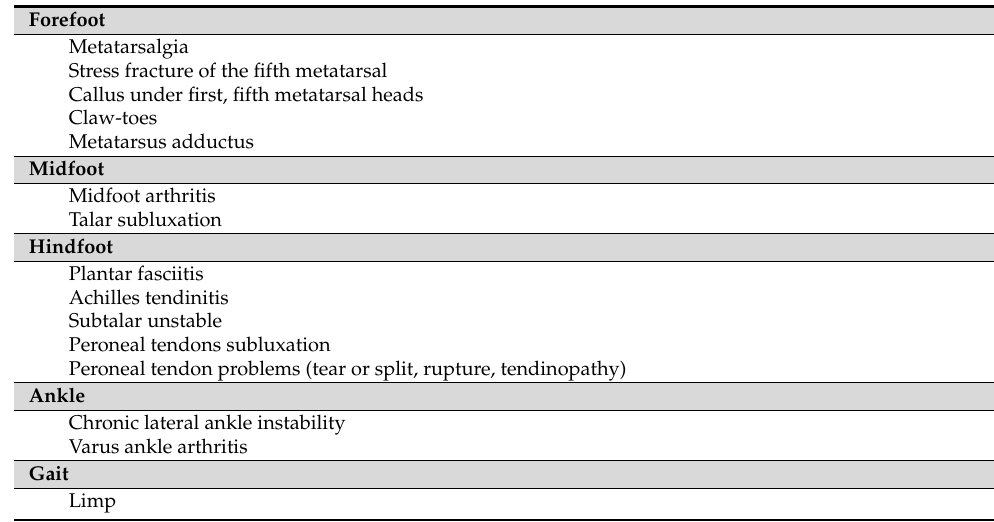
Table 2. Common associated manifestations of cavus foot.